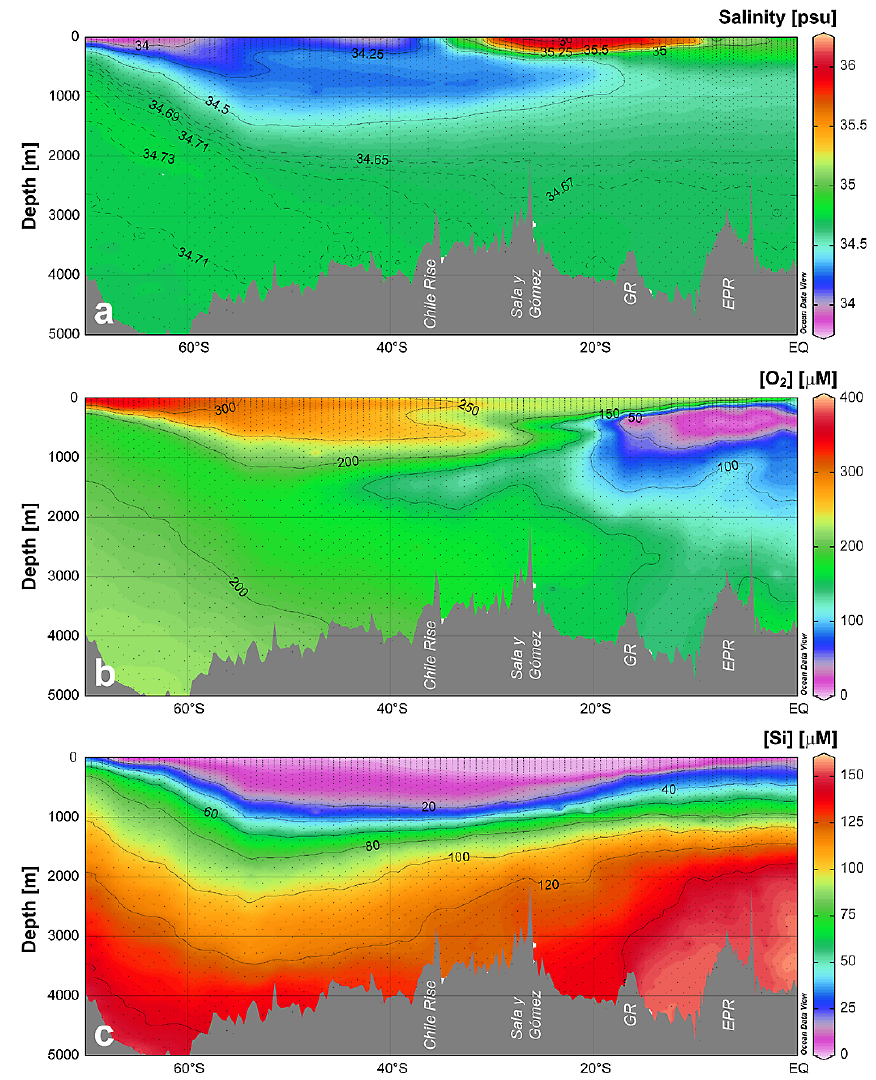
Fig. 2. South Pacific (a) salinity, (b) oxygen and (c) [Si] distributions along line P18 from expedition 33RO20071215. Note the difference in contour interval between the upper ocean (solid) and deep ocean (dashed) contours in panel (a) . See text for description of the main features. GR is the Gal ´ apagos Rise; EPR is the East Pacific Rise. Data are from the CLIVAR & Carbon Hydrographic Data Office (http: //cchdo.ucsd.edu/); color maps were produced using Ocean Data View (Schlitzer,